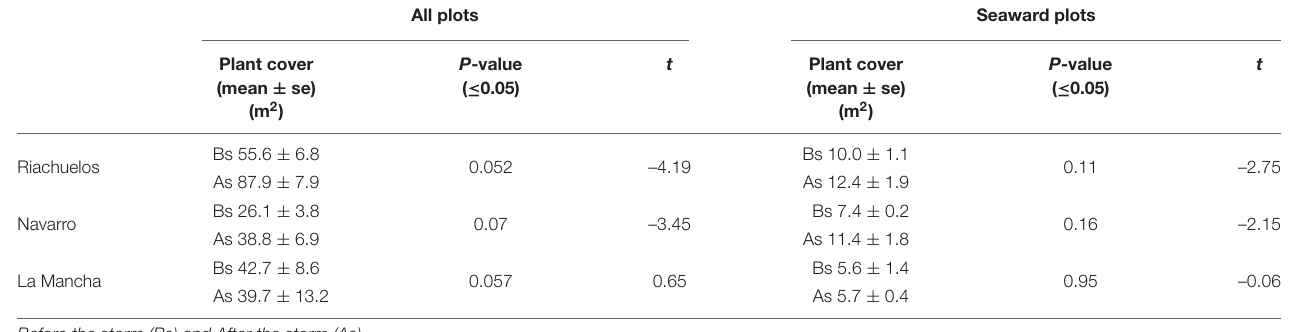
TABLE 2 | Mean plant cover, p -value, and t -test value for all the plots on the three beaches, and in the frontal plots. All plots Seaward plots